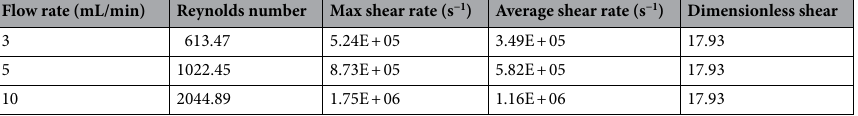
Table 2. Flow rates inside the shear device, with corresponding Reynolds number, maximum and average shear rates, and the dimensionless shear.